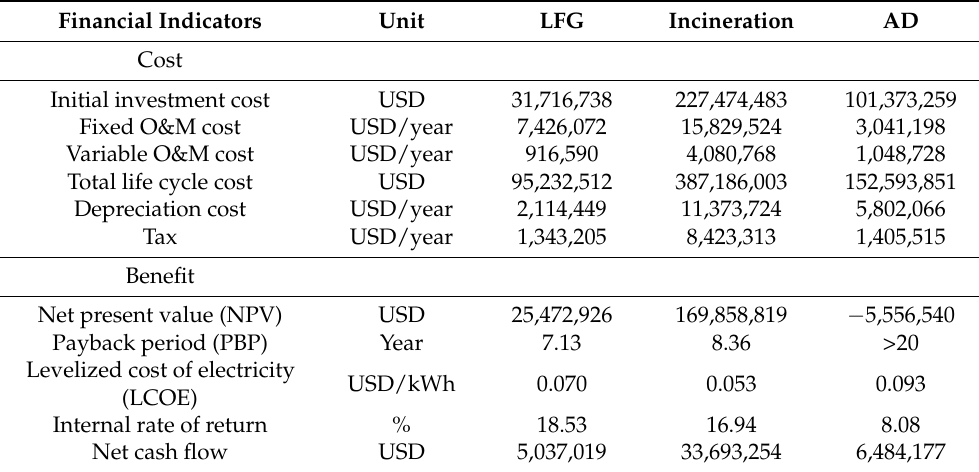
Table 7. Summary of economic feasibility assessment of the WTE